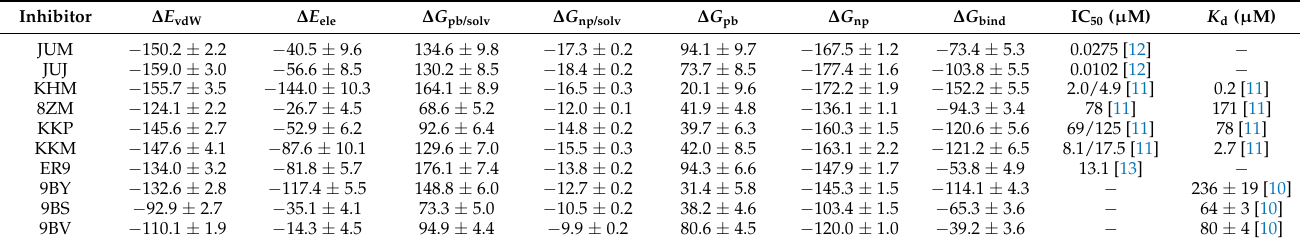
Table 2. The averaged binding free energies, ∆ G bind (kJ/mol), with the standard error of the mean for 10 hcGAS-inhibitor systems obtained from MM/PBSA calculations, along with other components. Here, ∆ G pb = ∆ E ele + ∆ G pb/solv and ∆ G ∆ E ∆ G np = vdW + np/solv